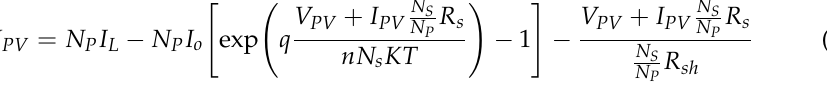
Table 1. Technical specifications of the PV module used in array modeling.